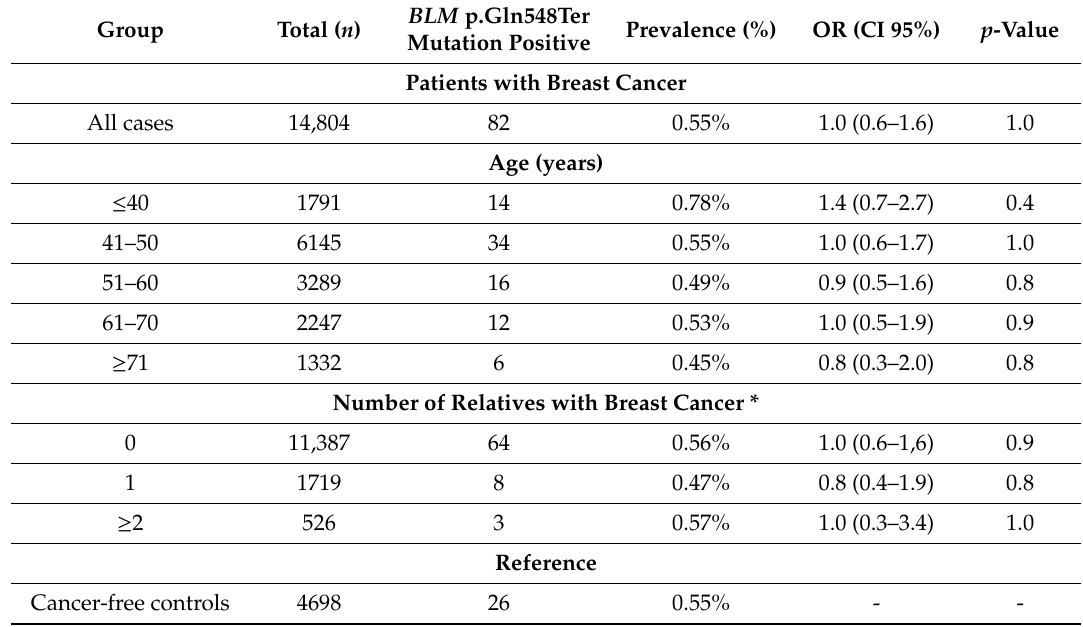
Table 1. Prevalence of BLM p.Gln548Ter founder mutation in 14,804 women with breast cancer, by age and family history and in 4,698 cancer-free